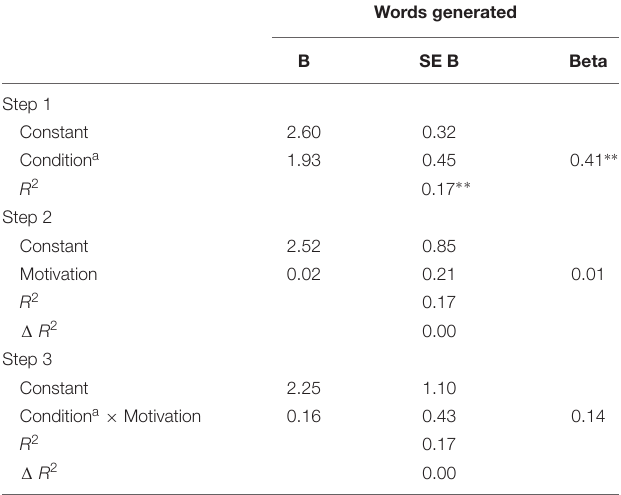
TABLE 3 | Linear regression model examining the main and moderating effect of motivation for weight management on number of weight loss related words generated ( n = 90).